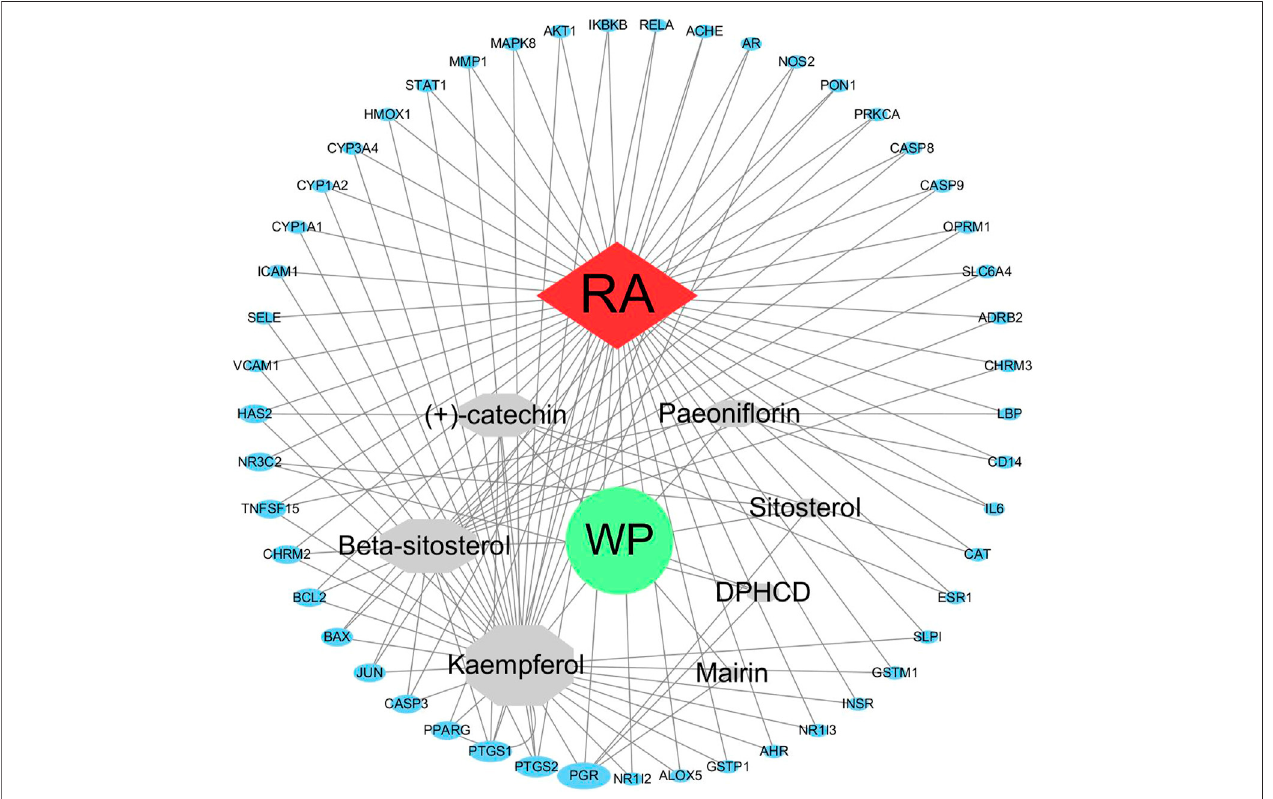
FIGURE 3 | The WP – RA-potential target gene network. The size of each node in the network represents the size of its degree value. The gray connecting lines indicate that each node is interconnected.